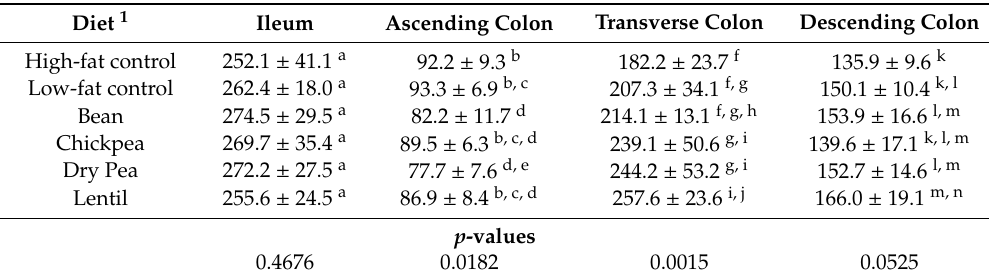
Table 1. E ff ect of feeding pulses on intestinal crypt